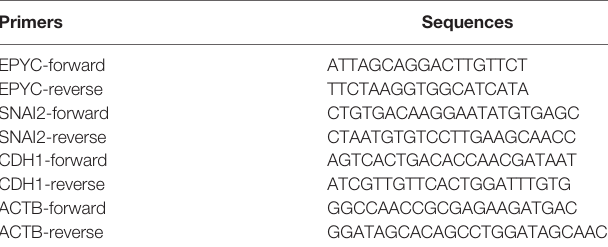
TABLE 1 | The primer sequences.